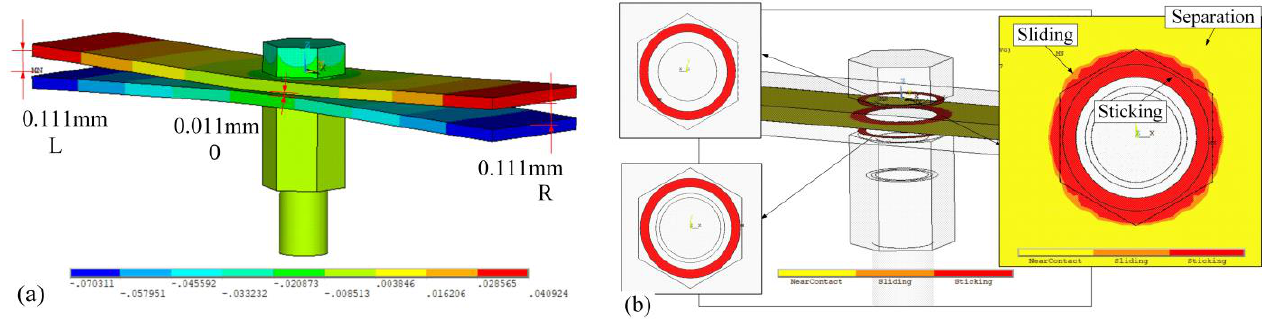
Figure 5. Nonlinear static analysis of the bolted joint, ( a ) displacements, and ( b ) contact status.